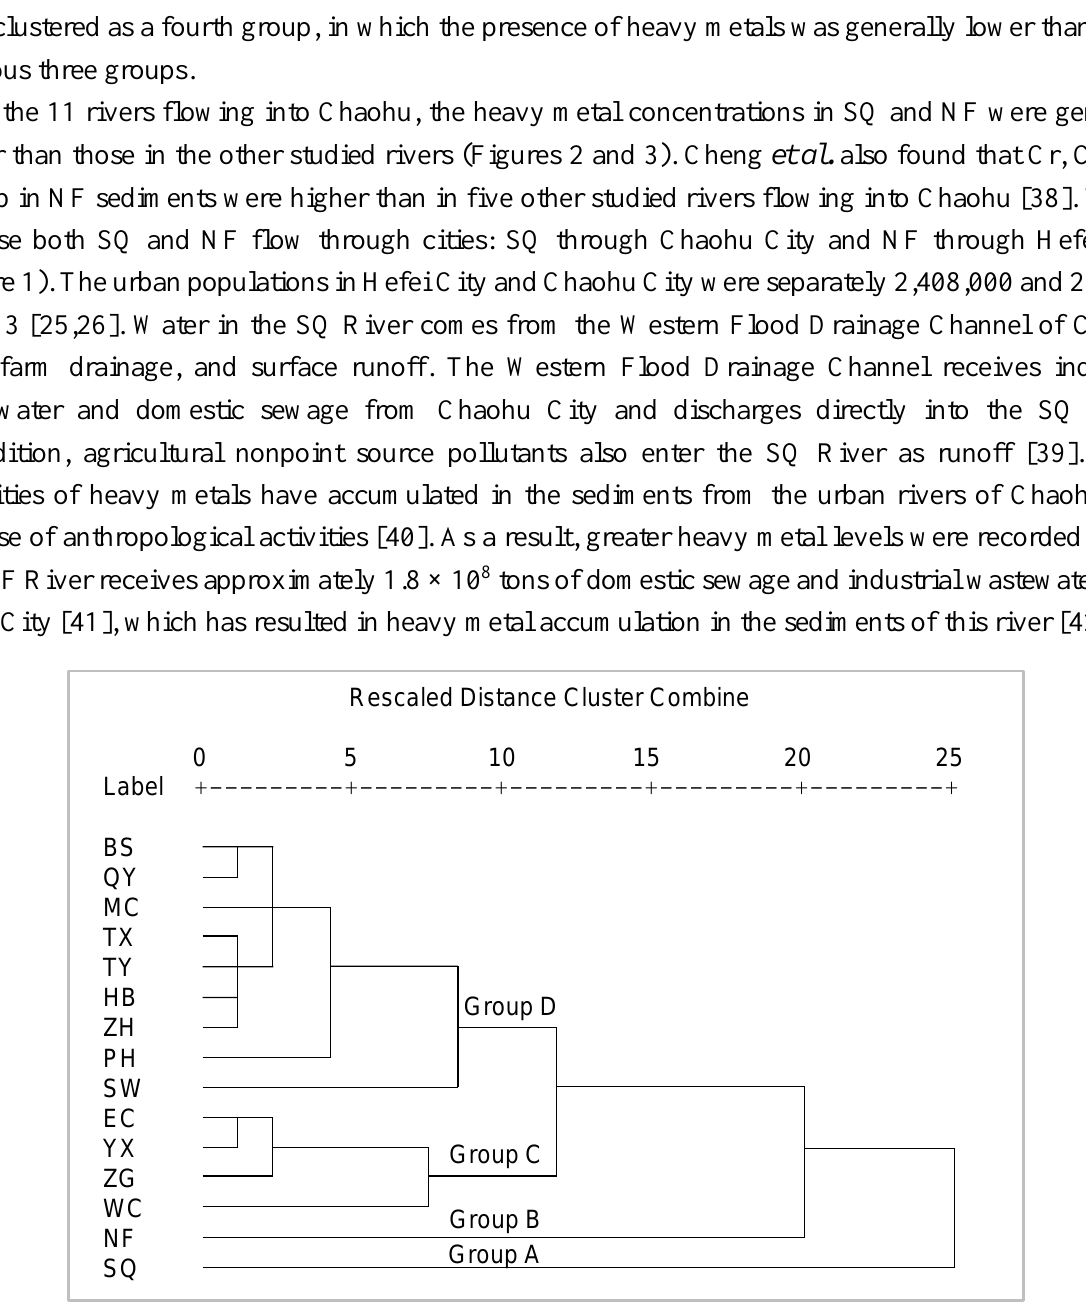
Figure 3. Dendrogram derived from the hierarchical cluster analysis of heavy metal concentrations in the analyzed